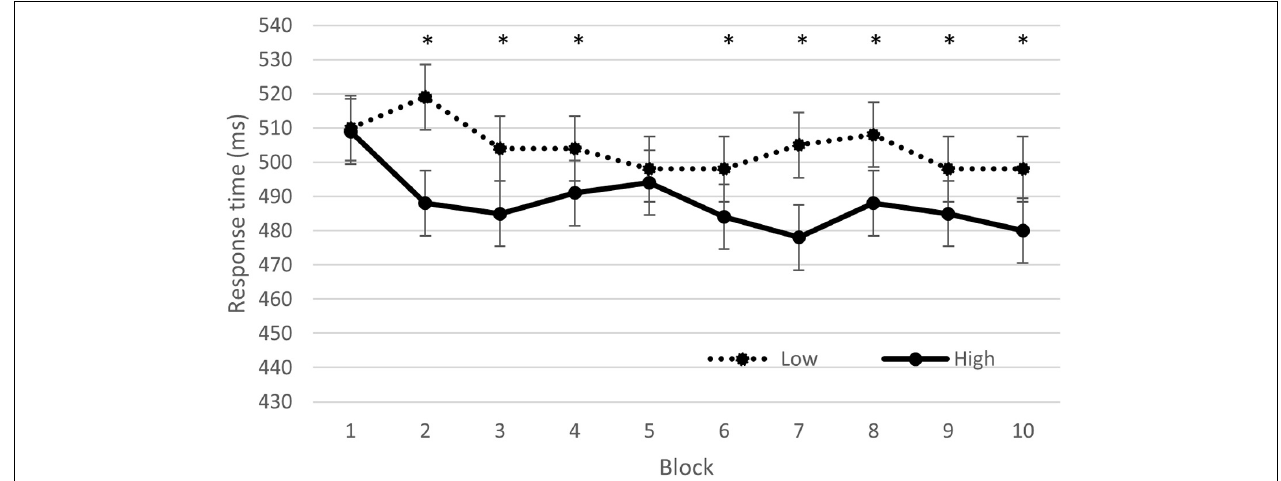
FIGURE 1 | Reaction time (ms) on the Eriksen task, as a function of time on task (block number), and condition (low vs. high intensity). ∗ indicates a significant difference ( p < 0.05) between the low and high condition.